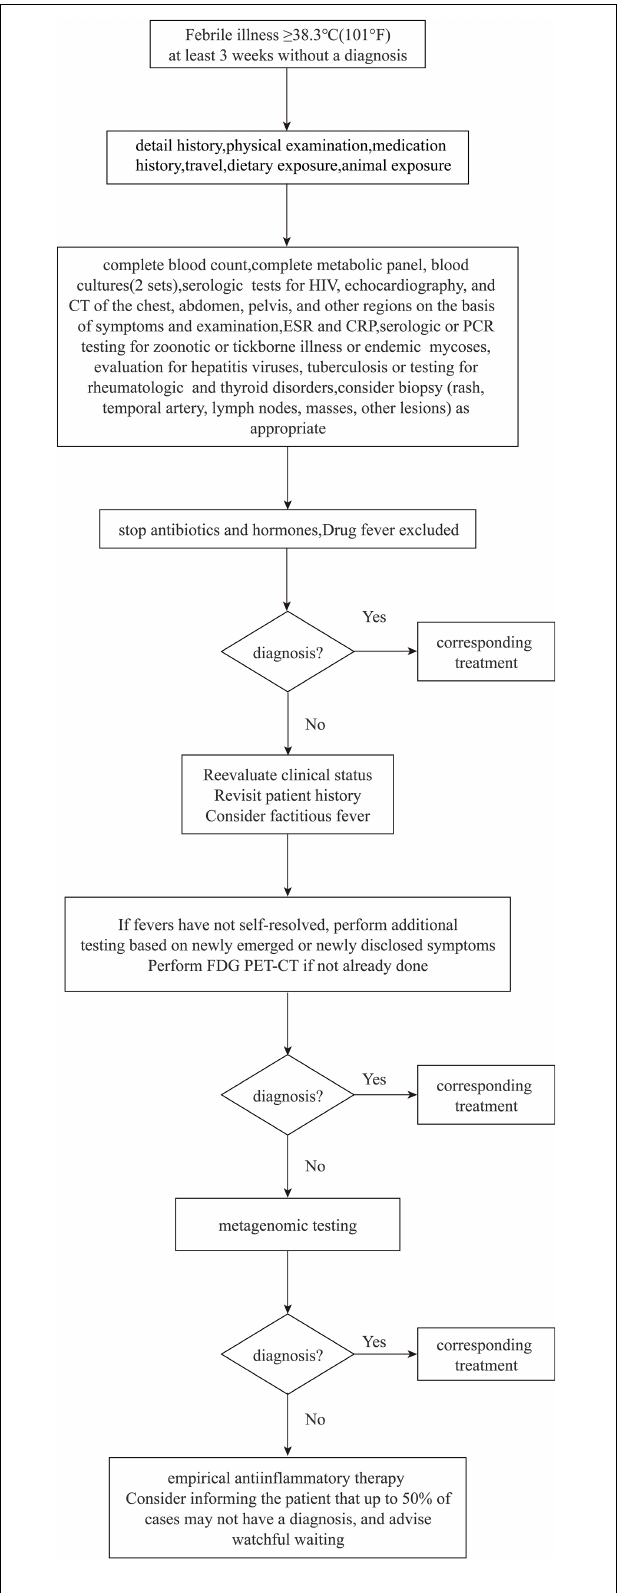
FIGURE 1 | FUO diagnosis and treatment flow